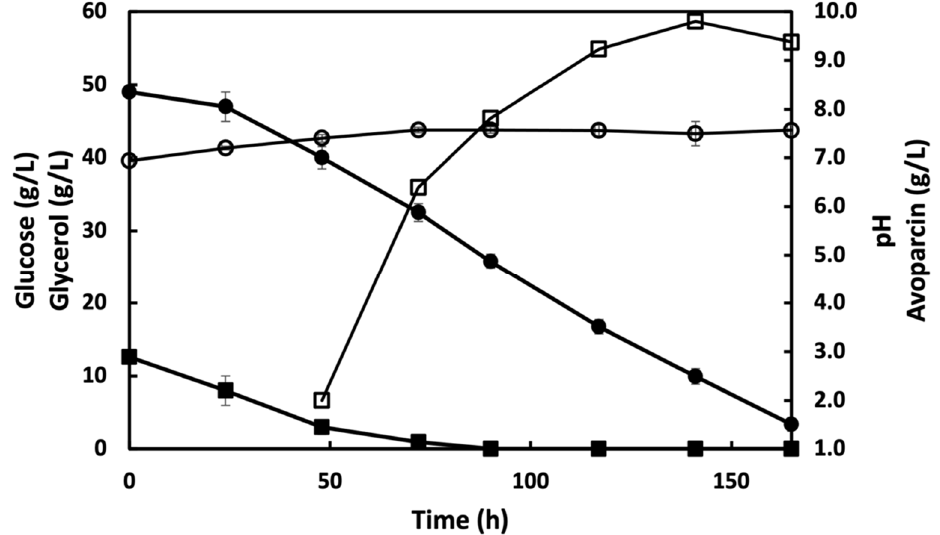
Figure 2. Time course of avoparcin complex production by A. coloradensis C14 cultivated in BCS360 medium. Glucose consumption (filled squares), Glycerol consumption (filled circles), pH (circles), and avoparcin complex production (squares) were monitored every 24 h. Avoparcin complex includes α - and β -avoparcin, and α - and β -ristosamynil-avoparcin.